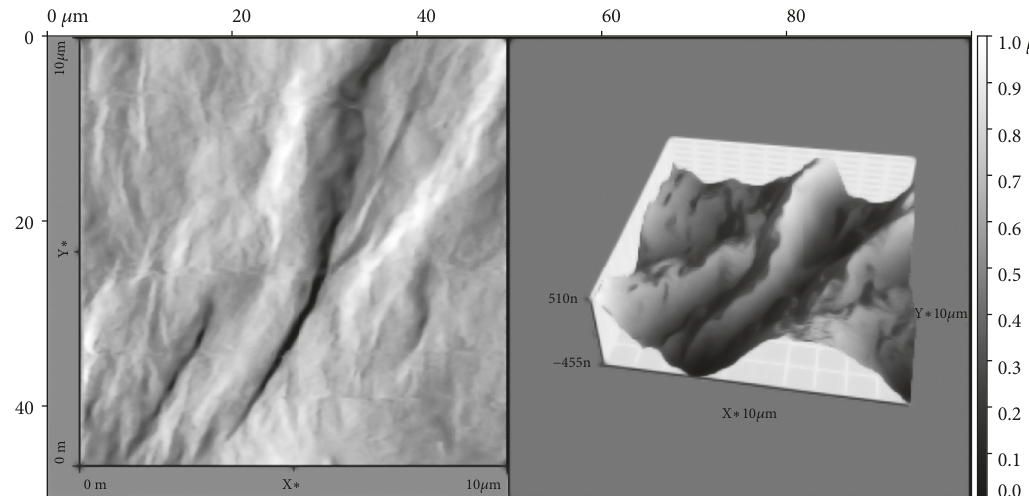
Figure 6: AFMimage and three-dimensional topography of vacuumoven-driedgrapheneoxide solution taken using the DD-ACTAprobe. A crevasse region runs through the center of the sample, with elevated regions on either side.